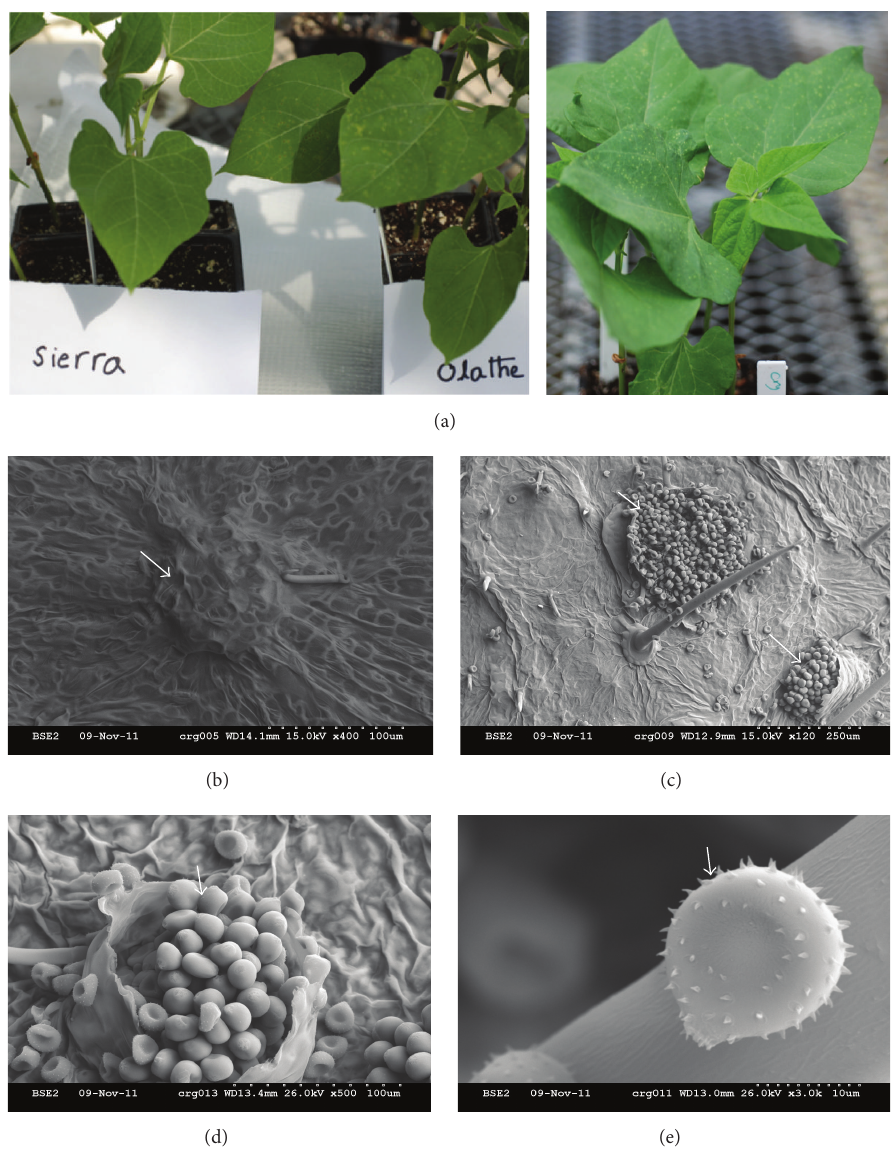
Figure 1: Common bean rust symptoms, rust pustules, and spores. (a) Ten-day-old seedlings at the primary leaf stage were inoculated with rust race 53. The susceptible genotype Olathe and susceptible mutant crg developed visible rust like symptoms after approximately 10 days of inoculation, whereas the resistant genotype Sierra was asymptomatic as expected. The genotypes Olathe and crg were used as an inoculation experimental control only and are shown here. (b–e) Scanning electron microscope pictures from a leaf of a rust susceptible genotype crg after symptoms were developed. Picture (b) is an unopened rust pustule. ((c) and (d)) Pustules which burst open at 120 and 500 times’ magnification. (e) Rust spore under 3000 times’ magnification. White arrows point to the pustules and fungal